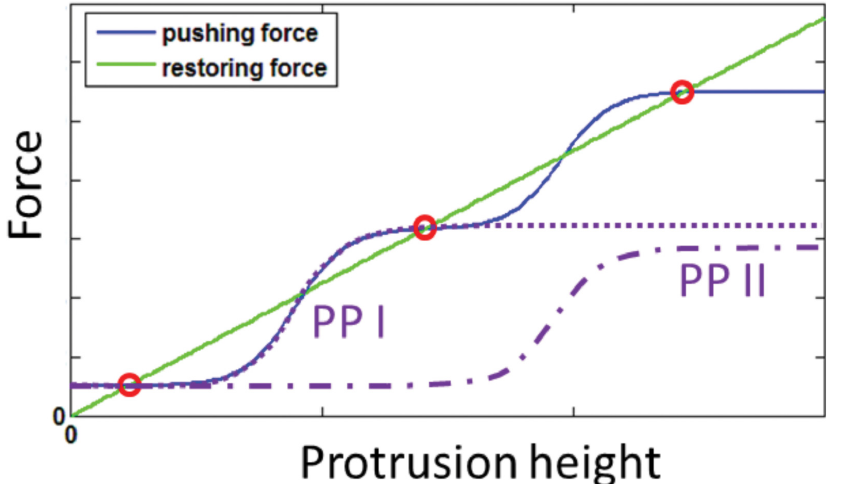
Fig 1. The pushing force resulting from two different promoters of actin polymerization, with different saturation heights, may result in multiple steady-state solutions. The purple dash-dot and dotted lines are the concentration profiles of the two promoters at the tip. The blue line is the pushing force due to the polymerization rate determined by the promoter concentrations at the tip, and the green line is the restoring force, which is dominated by actin-membrane myosin connectors. The red circles mark the stable steady- state heights, h st (Eq